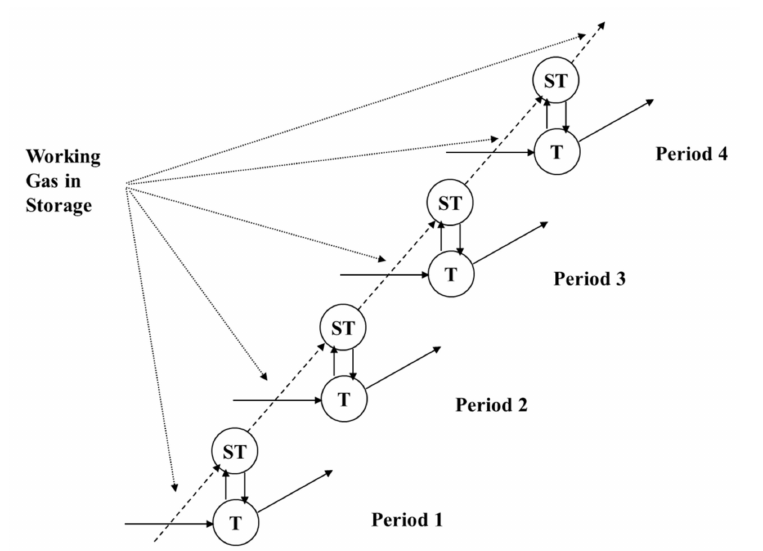
Figure 2. Storage in a network